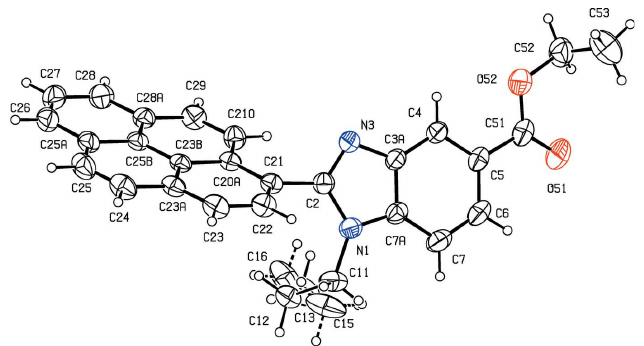
Figure 2 The molecular structure of compound (II) showing the atom-labelling scheme and the disorder. The major disorder form is drawn using full lines and the minor disorder component is drawn using broken lines. Displacement ellipsoids are drawn at the 30% probability level.